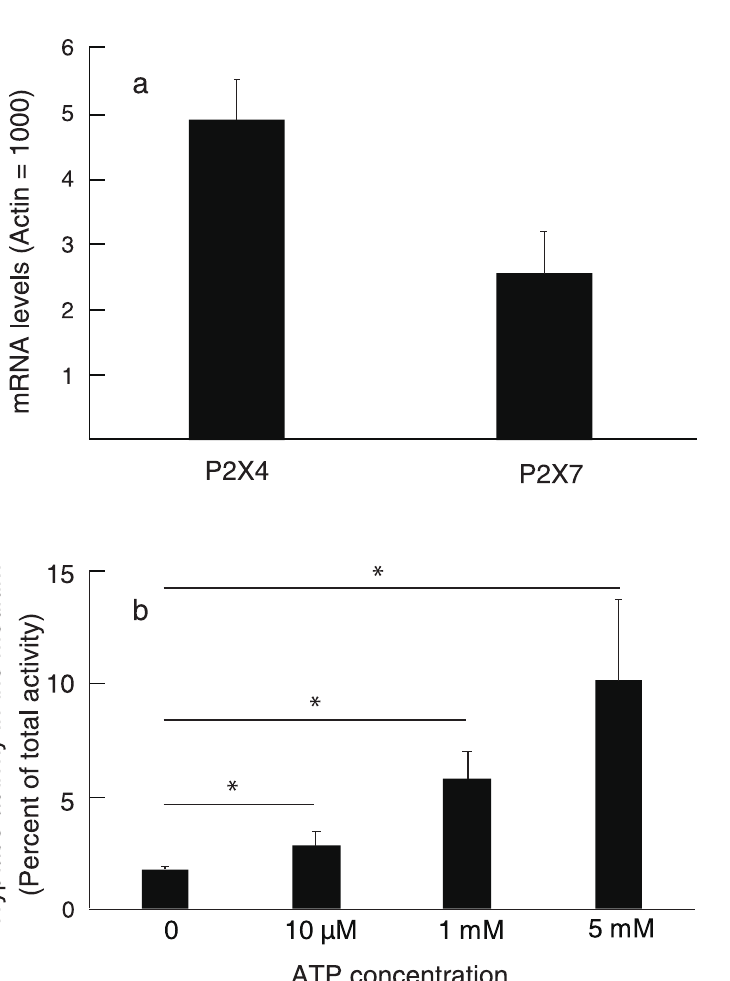
Fig 11. Expression of mRNA of P2X4 and P2X7 in BMMC (a) and effects of ATP on the release of tryptase from BMMCs (b). a, Height of bars represents ratios of the gene expression of P2X4 and P2X7 to the gene expression of β - actin in BMMCs. SDs were shown above bars. b, Height of bars represents the ratios of tryptase activity in the medium to the total tryptase activity (sum of the activity in the medium and the cell pellets). Four independent experiments were carried out. SDs were shown above bars. � p <